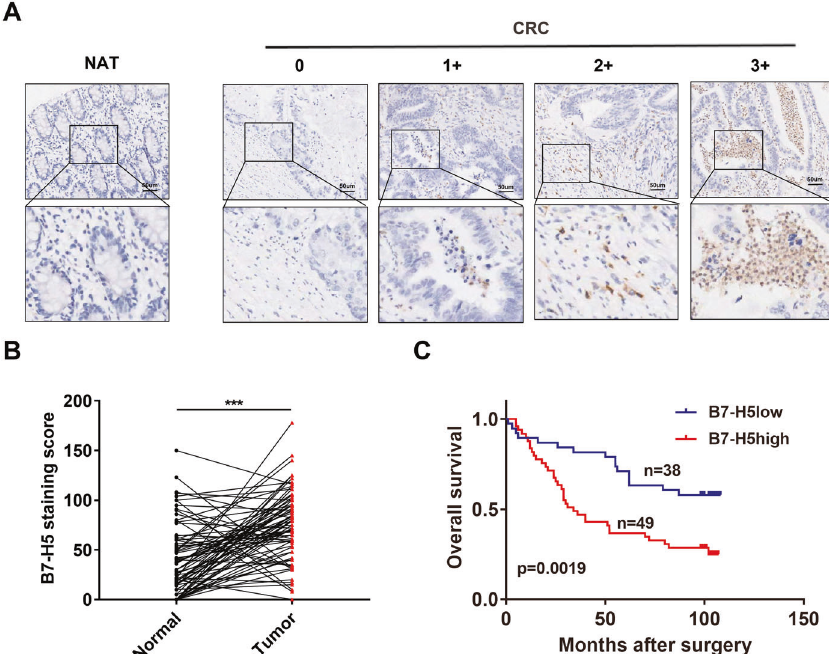
Fig. 1 B7-H5 was abnormally expressed in CRC. A Representative B7-H5 IHC staining pattern of human CRC tissue and normal adjacent tissue (NAT). The staining score ranged from 0 to 3. B B7-H5 protein expression based on its staining index in CRC and NAT specimens. C The overall survival of patients with high or low B7-H5 expression was analyzed by Kaplan − Meier method ( P = 0.0019). Values are expressed as means (SEMs). *** P <